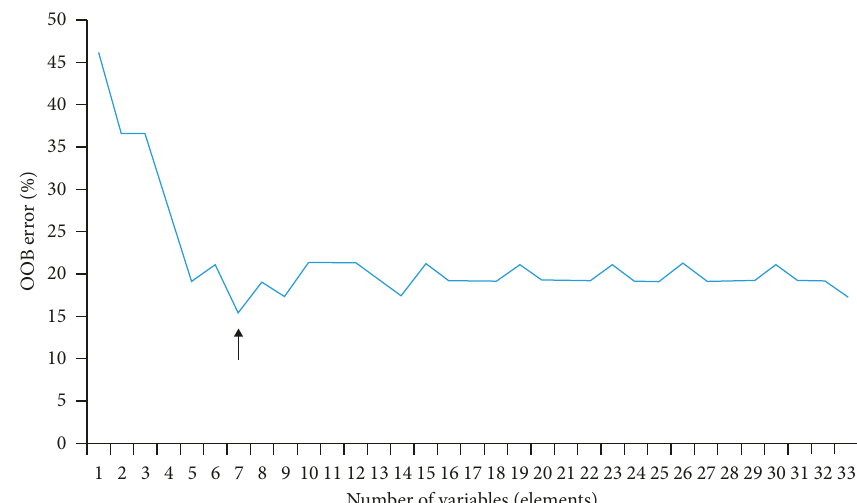
Figure 6: Finding the best subset of classification variables for classifying nonsites, middens, vitrified dung, and nonvitrified dung sites using the FVS method based on the OOB error. The black arrow points to the optimal subgroup of elements with the lowest error.